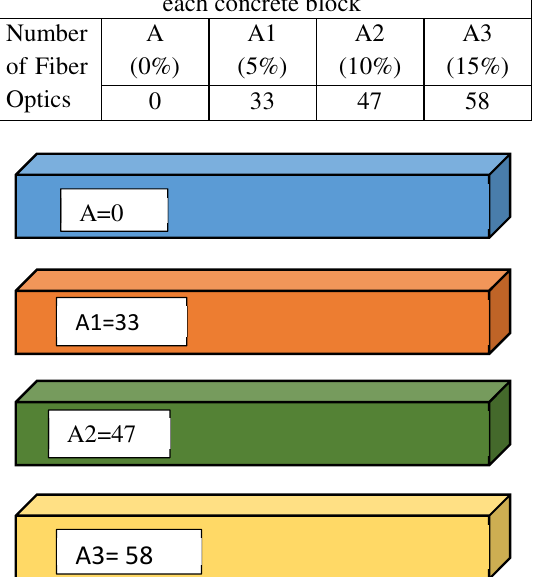
Fig. 6: Notes - Calculations determining the surface area of each block and number of fiber optic strands required for each block